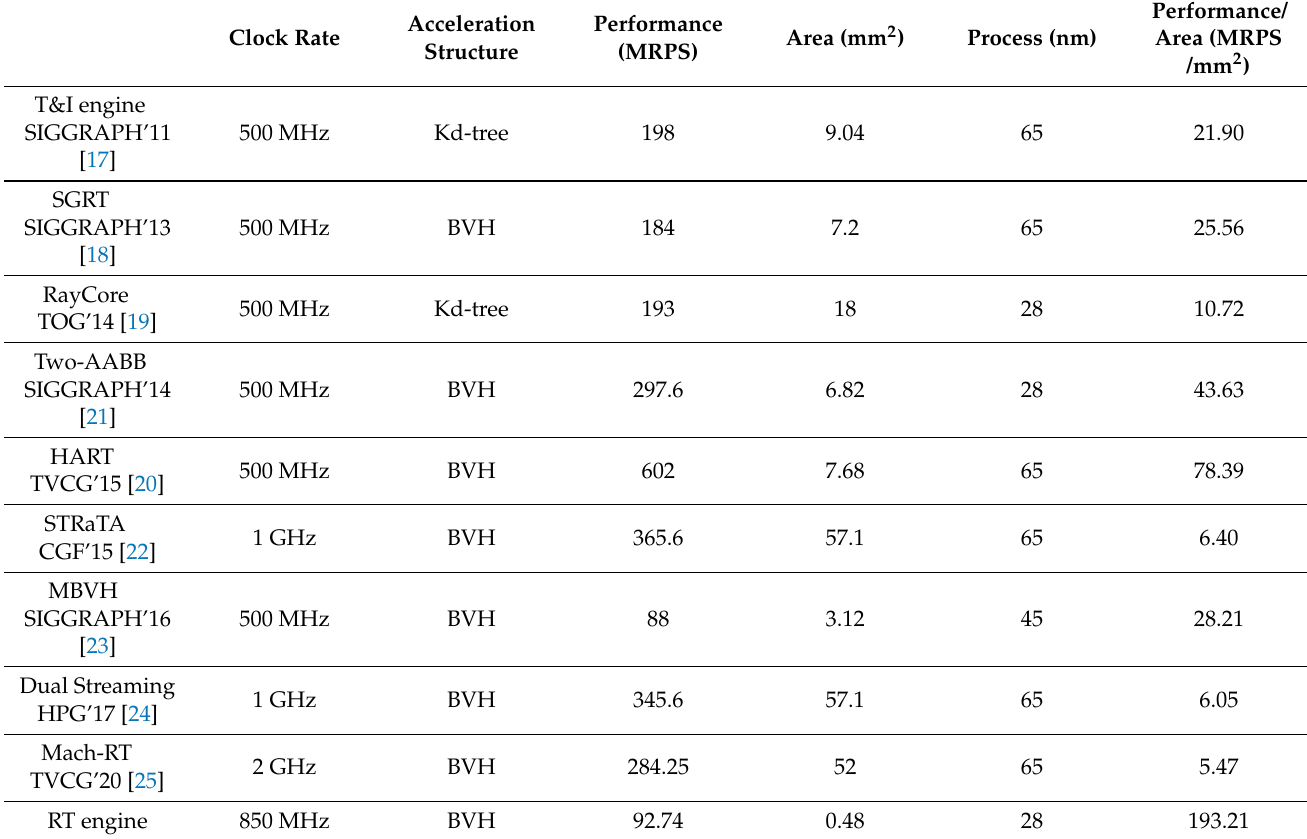
Table 7. Performance comparison against previous